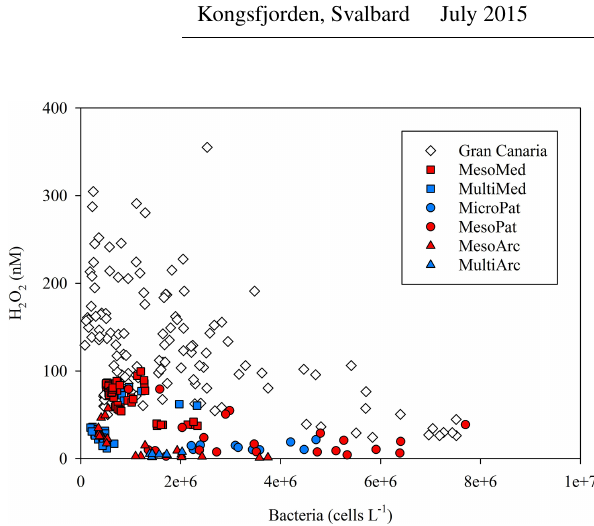
Figure 10. Bacterial cell counts and H 2 O 2 for all available data from all incubation experiment time points where both measure- ments were made within 24h of each